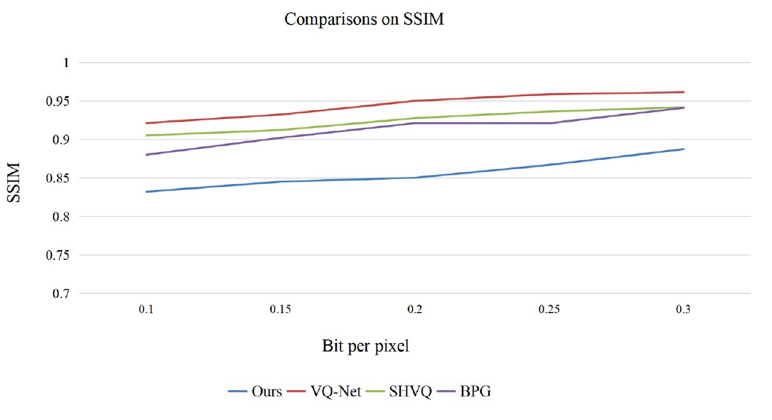
Fig 16. Comparisons on